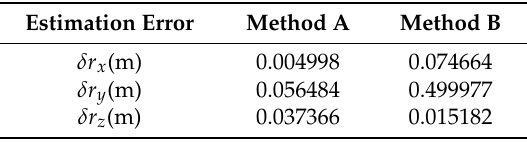
Figure 9. The estimation errors of the coupling angles. ( a ) The x-axis dynamic lever arm error; ( b ) The y-axis dynamic lever arm error; ( c ) The z-axis dynamic lever arm error. Table 2. The RMSE of the dynamic lever arm.